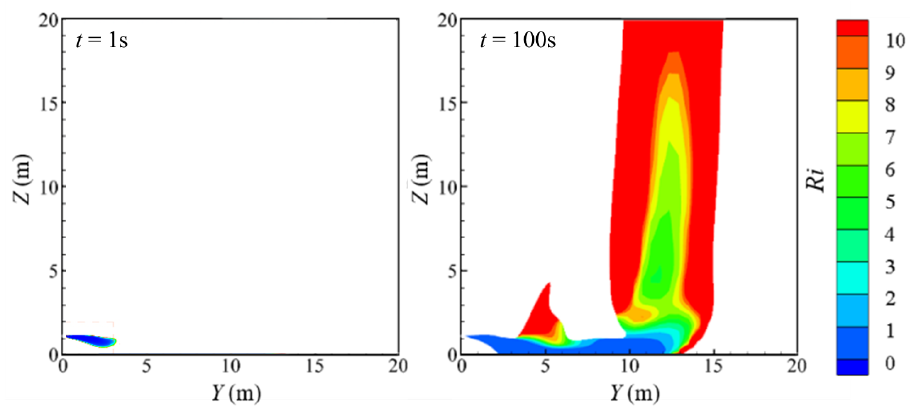
Figure 8. Distribution of R i number at various times.